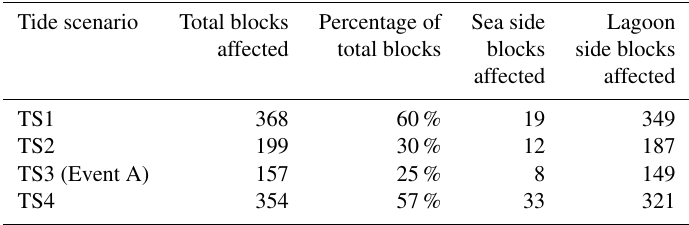
Table 2. Blocks of Progreso affected as a function of tidal phase during Event A. Tide